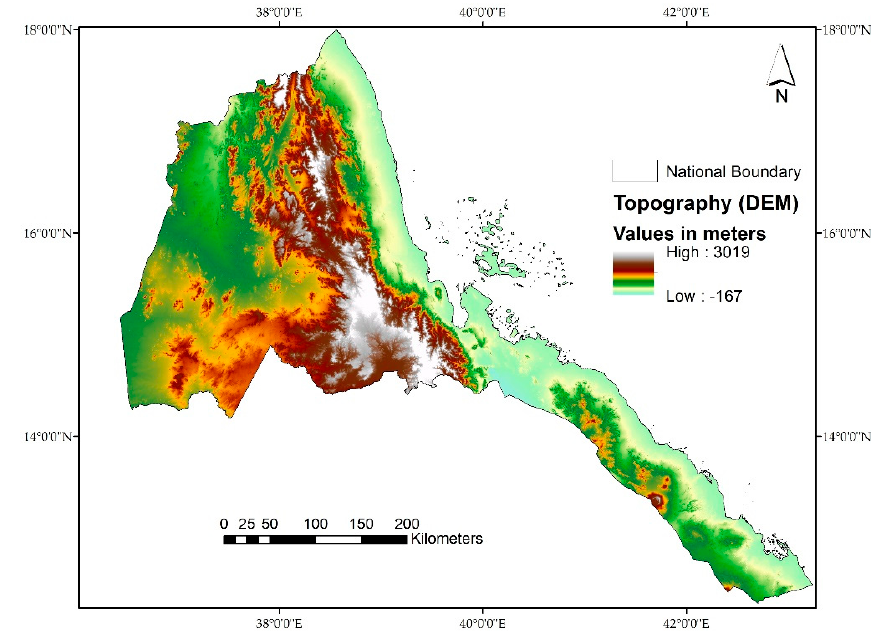
Figure 3. Topographic map of Eritrea (Digital Elevation Modelsource: Shuttle Radar Topography Mission 30-m resolution).